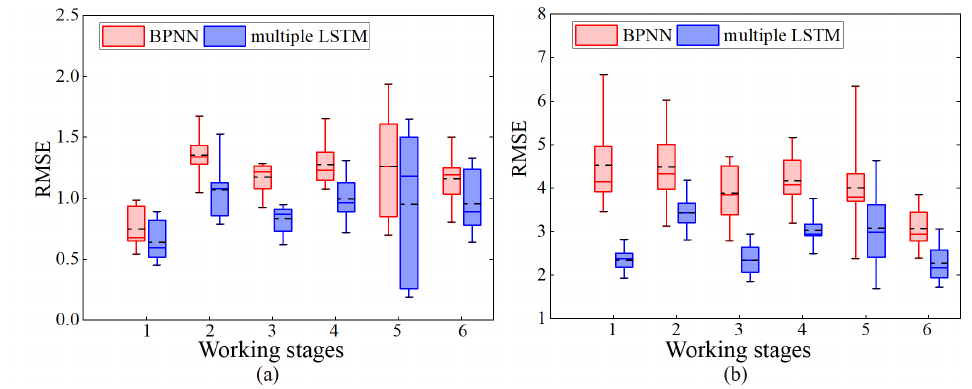
Figure 12. RMSE comparison of BPNNs and LSTM networks using small coarse gravel: ( a ) prediction of throttle value ( b ) prediction of state.